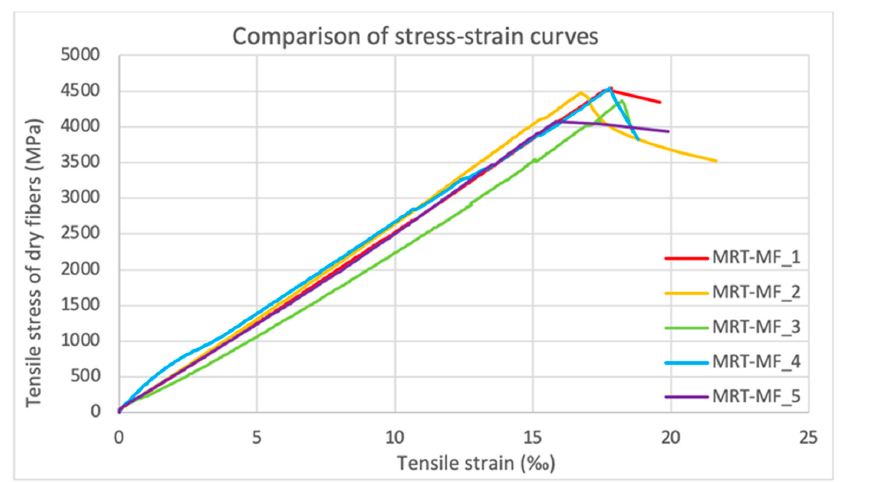
Figure 6. Mode of failure of the specimens.